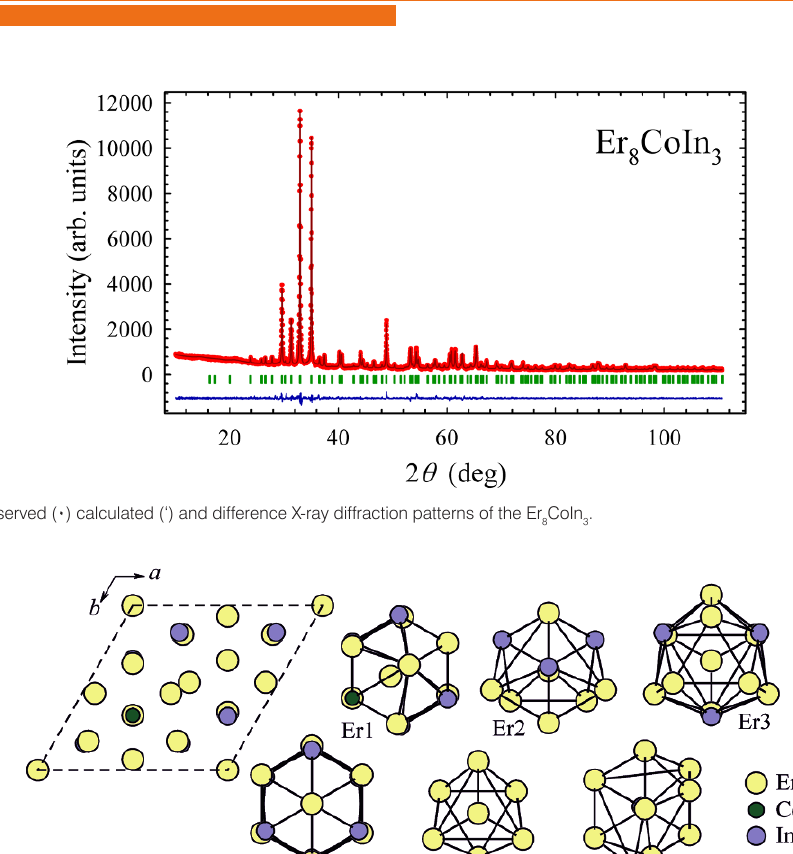
CoIn compound on ab plane and coordination polyhedra of 8 3